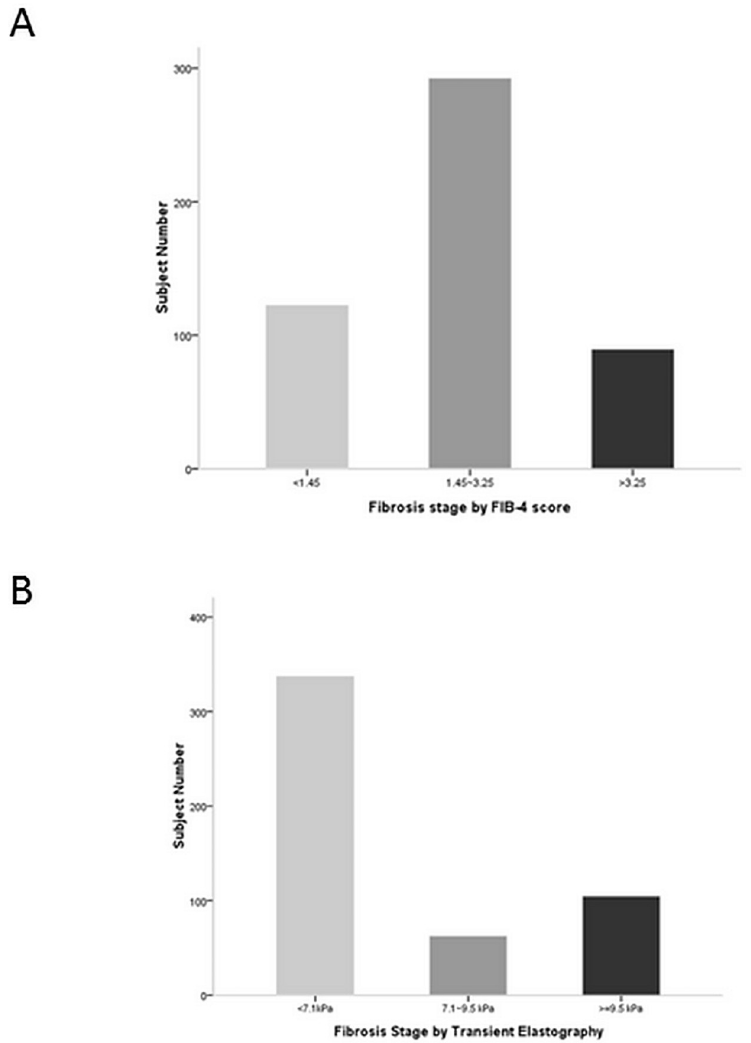
Fig 1. Fibrosis distribution. Fibrosis distribution of fibrosis severity according to (A) FIB-4 score or (B) Transient elastogrpahy. https://doi.org/10.1371/journal.pone.0206947.g001 Sixty-three subjects (41.4%) would not have been identified as such if the FIB-4 score had been used alone. Similarly, the advanced fibrosis of 46 subjects (30.3%) would have been missed by using only TE. The univariate analysis revealed that subjects with advanced fibrosis in the TE group were younger, had higher platelet counts, higher body mass index (BMI), higher inci- dence of fatty liver, higher CAP values, higher incidence of splenomegaly, and lower FIB-4